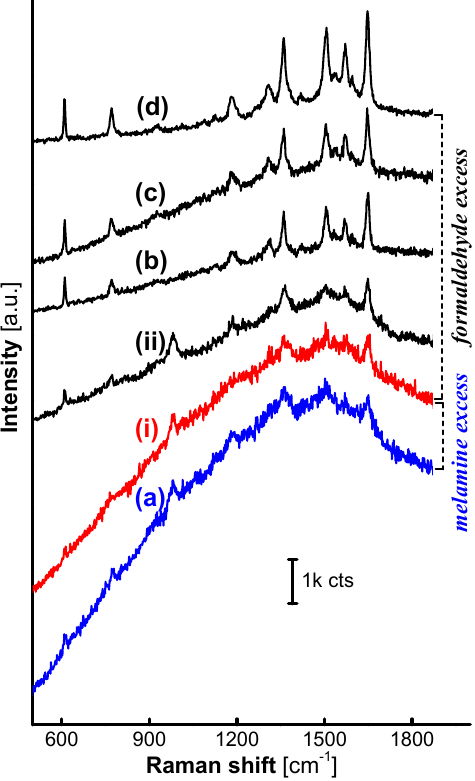
Figure 9. SERS spectra from R6G on the AgNPs treated with the solutions, which had impregnated the MFMSs synthesized with a set of F:M molar ratios in 3 h. ( a ) MF 1 ; ( i ) MF 1.5 ; ( ii ) MF 2 ; ( b ) MF 3 ; ( c ) MF 7 ; and ( d ) MF 9 .